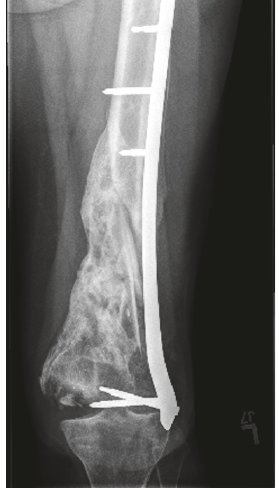
Figure 5: AP radiograph of distal femur.